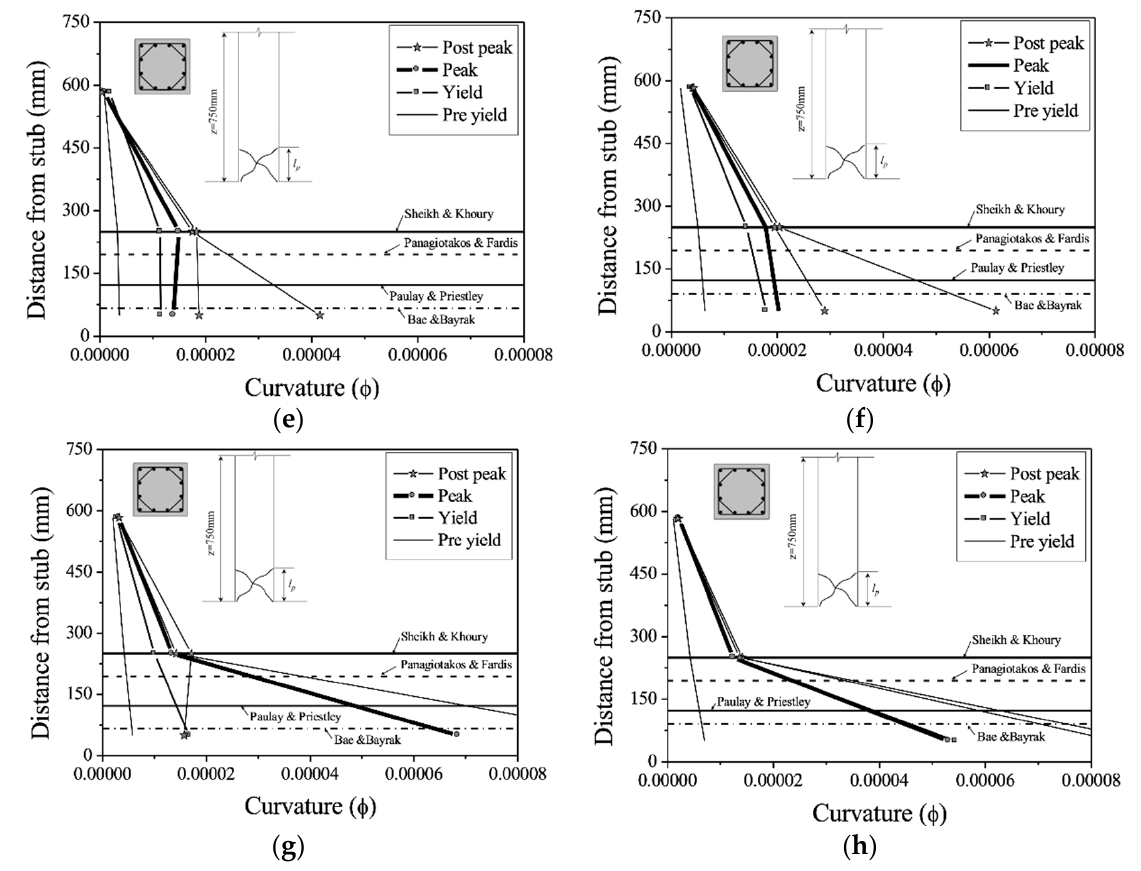
Figure 10. Relationship of plastic hinge-curvature of specimens: ( a ) NH20; ( b ) NH30; ( c ) UH20; ( d ) UH30; ( e ) NS20; ( f ) NS30; ( g ) US20; (h) US30.